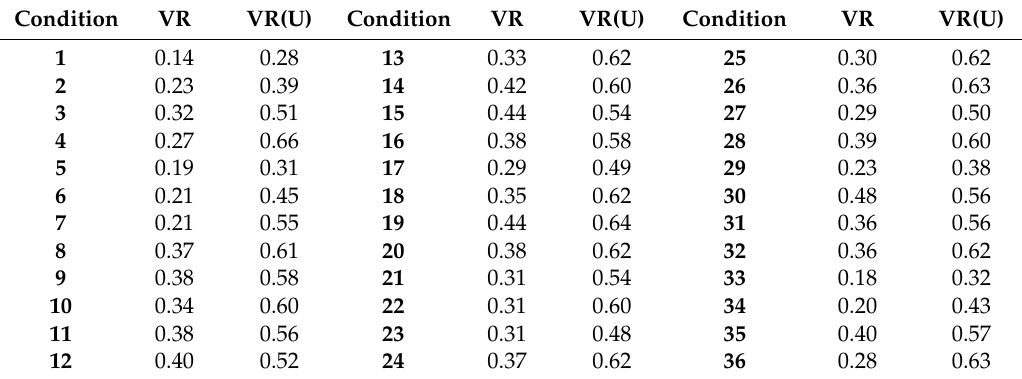
Table 4. Volumetric ratios of the produced joints. Table 4 . Volumetric ratios of the produced joints.